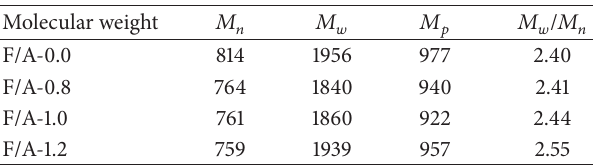
Table 6: The average molecular weights of the base asphalt after UV aging.